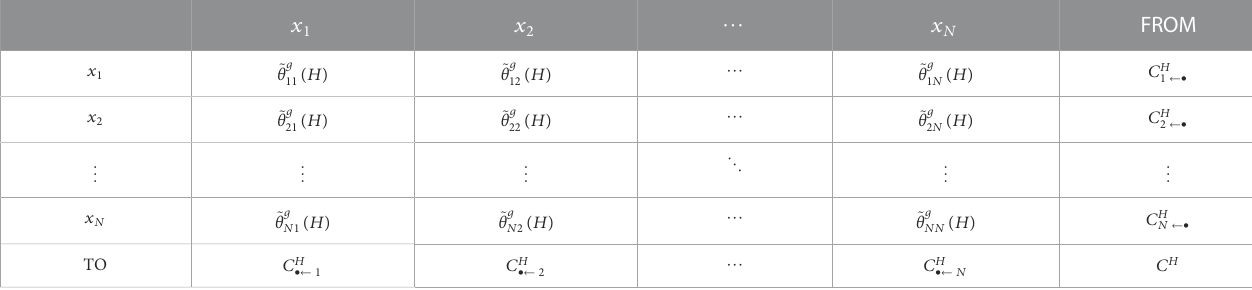
TABLE 1 Risk spillover